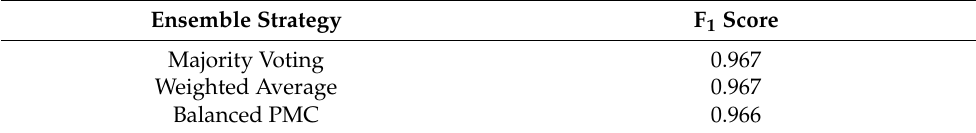
Table 2. Results of the ensemble strategies. Ensemble